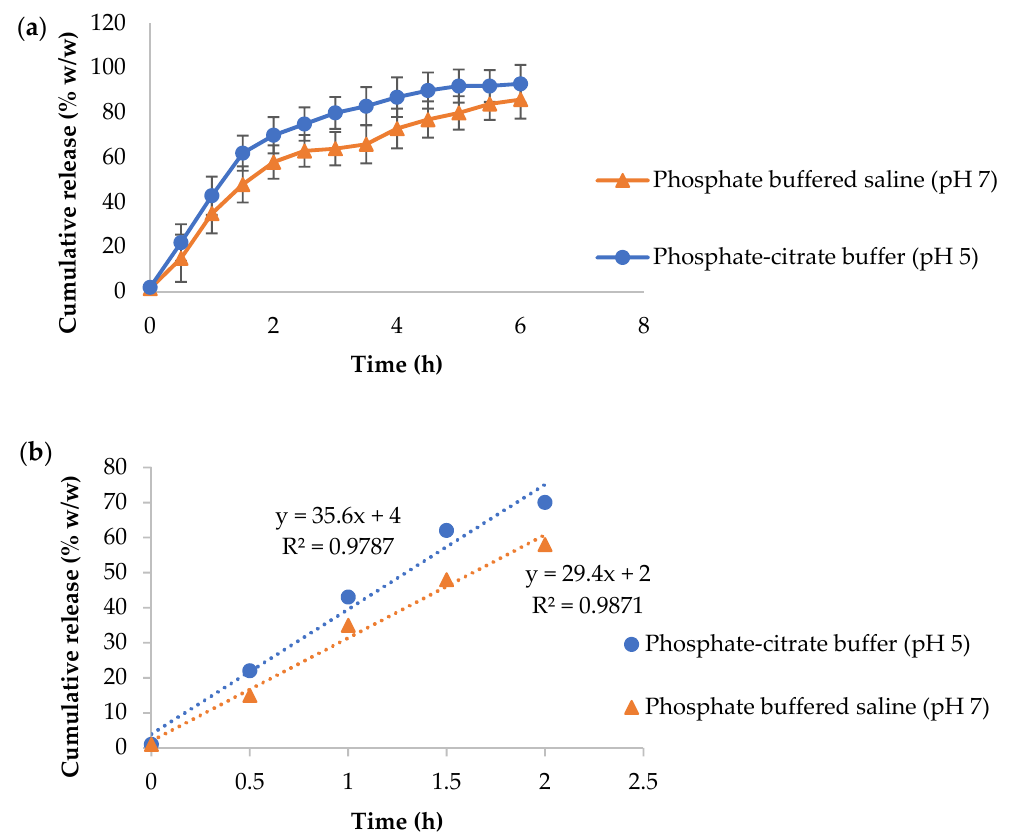
Figure 10. ( a ) Release profiles (0–6 h) and ( b ) linear regression profiles (0–2 h) of α -arbutin release from BMO-PUL nanocarriers (2 mg/mL) in either phosphate-citrate buffer (pH 5) or phosphate-buffered saline (pH 7) medium ( n = 3; ± SD). Table 5. Quality of the fit (expressed as squared correlation coefficient, R 2 ) for different kinetic mod- els describing the release of α -arbutin from BMO-PUL nanoparticles. pH Medium